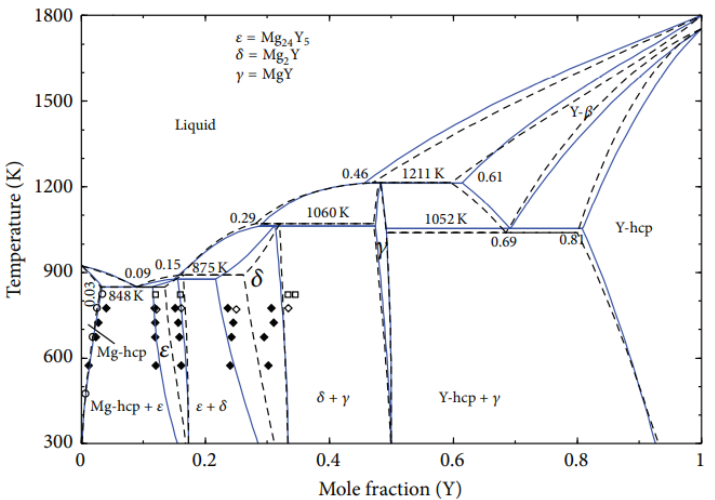
Figure 6. Mg-Y phase diagram solid lines [97] in comparison to [120] showed in dotted line [77].